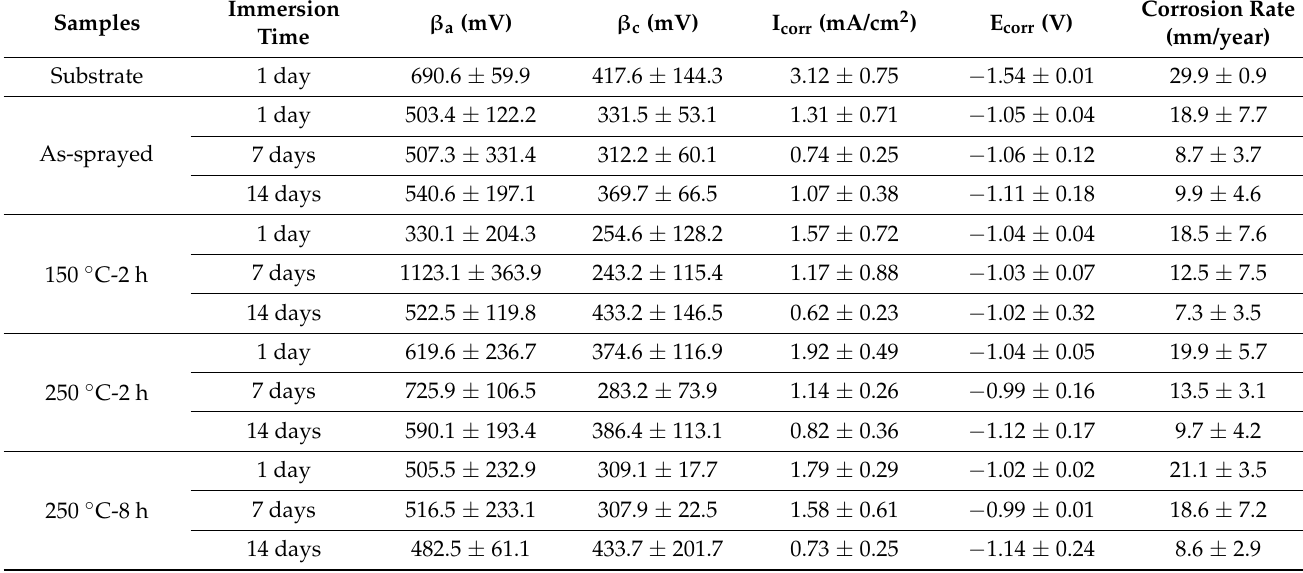
Table 1. Fitting results from polarization curves in Figure